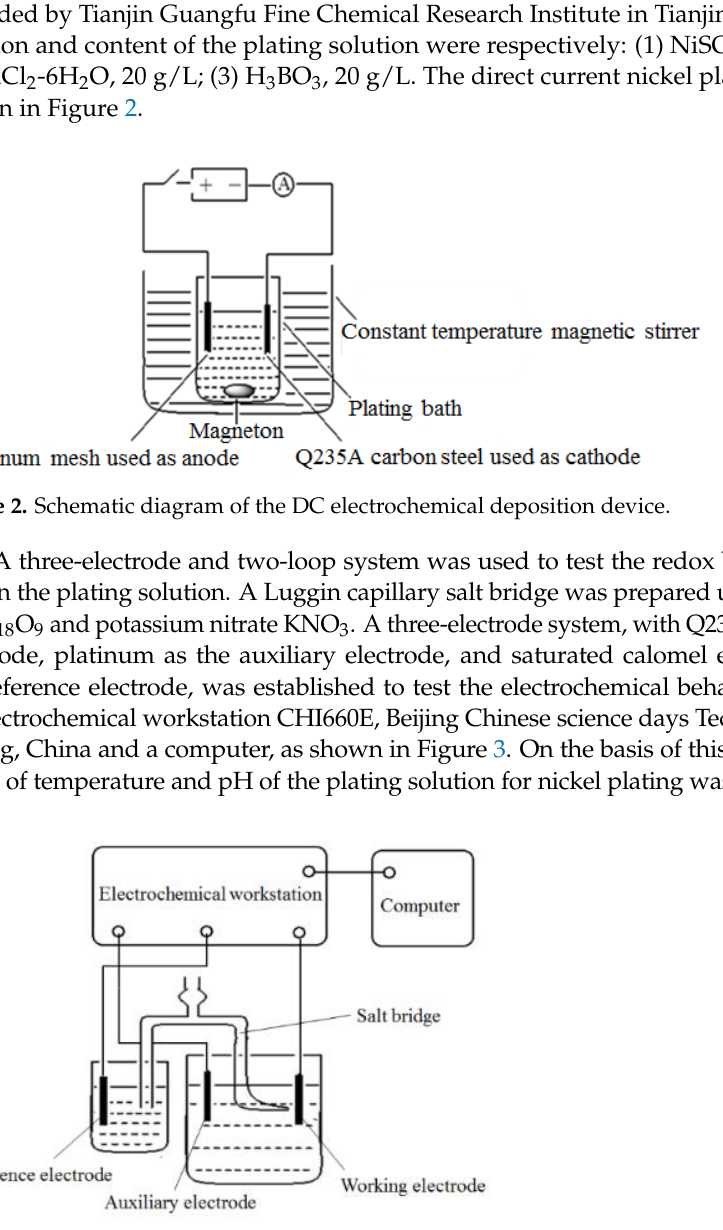
Figure 3. Diagram of the electrochemical test circuit and system.